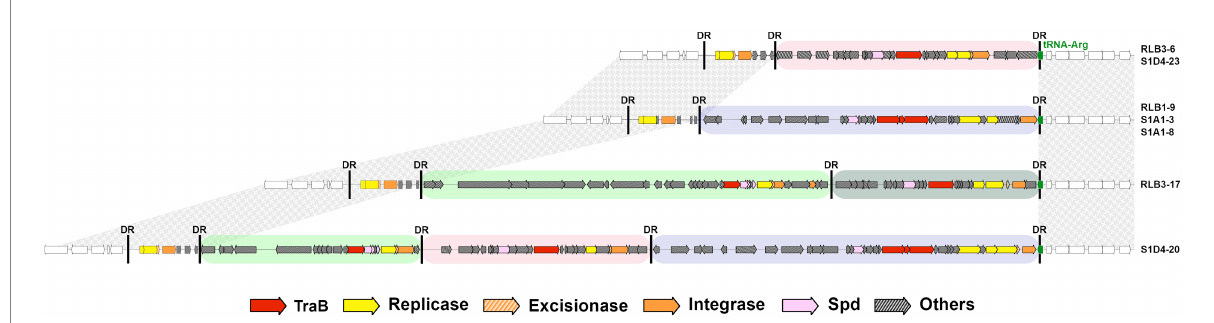
FIGURE 2 Accretion of AICEs and DAICEs at an insertion hot spot. An illustration of the diversity of conjugative elements within the same tRNA-Arg gene shared by different strains of the population (located ca. 8 Mb relative to RLB1-8 chromosome) as well as in some cases the multiple integration of several elements within this site (i.e., accretion). This is the case for strains RLB3-17 and S1D4-20 that harbor two and three functional elements, respectively. All strains share a conserved remnant element devoid of traB between their left-hand direct repeats (DR). The black vertical bars represent direct repeats, and the colored boxes represent the different AICE families (green: AICE05, grey: AICE16, pink: AICE17, purple: AICE18). Synteny on either side of the accretion site is indicated by textured grey areas. Genes are colored according to functions: inter or intra mycelial transfer, replication, excision/integration and others (legend below the figure).